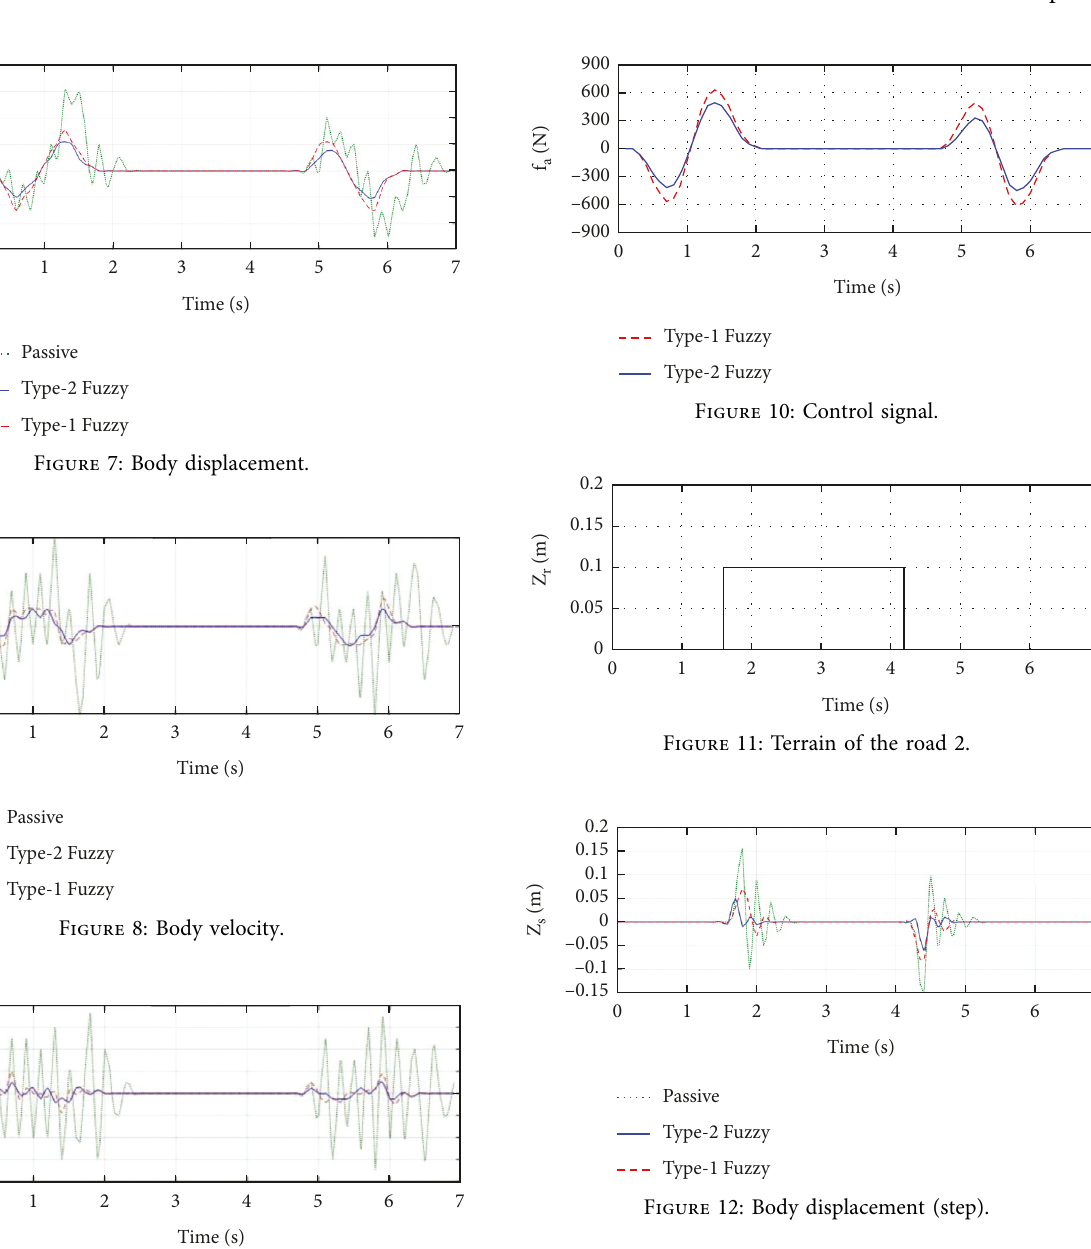
Figure 12: Body displacement